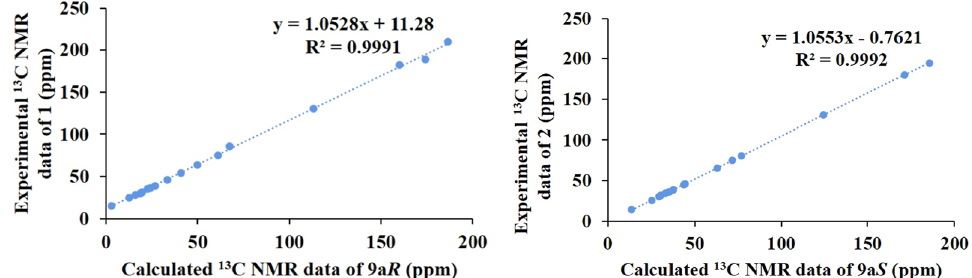
Fig. 3 Correlation plots of experimental and 13 C NMR spectral data for 1 and 2